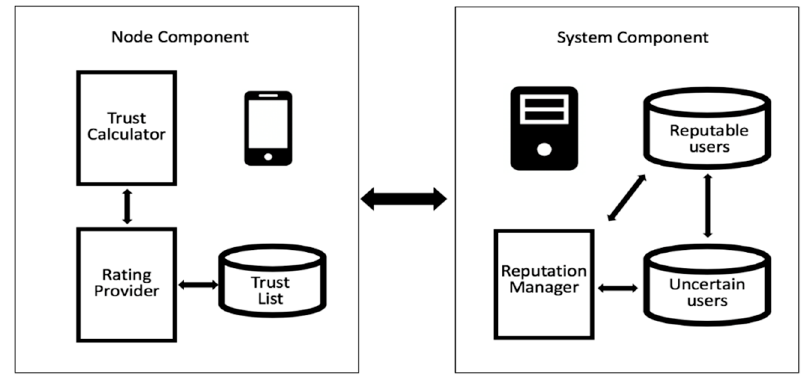
Figure 3. WhatsTrust architecture.